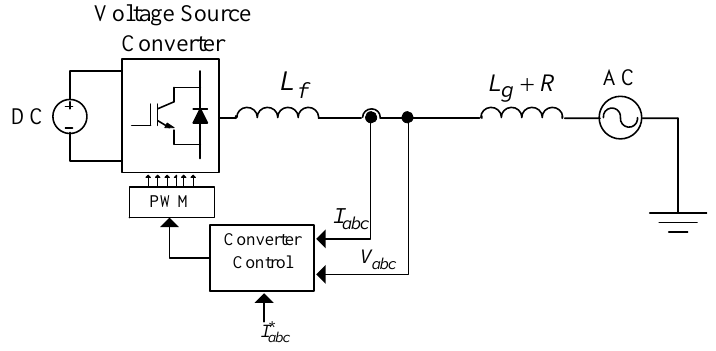
Figure 3. A Grid-connected VSC working in the grid-feeding